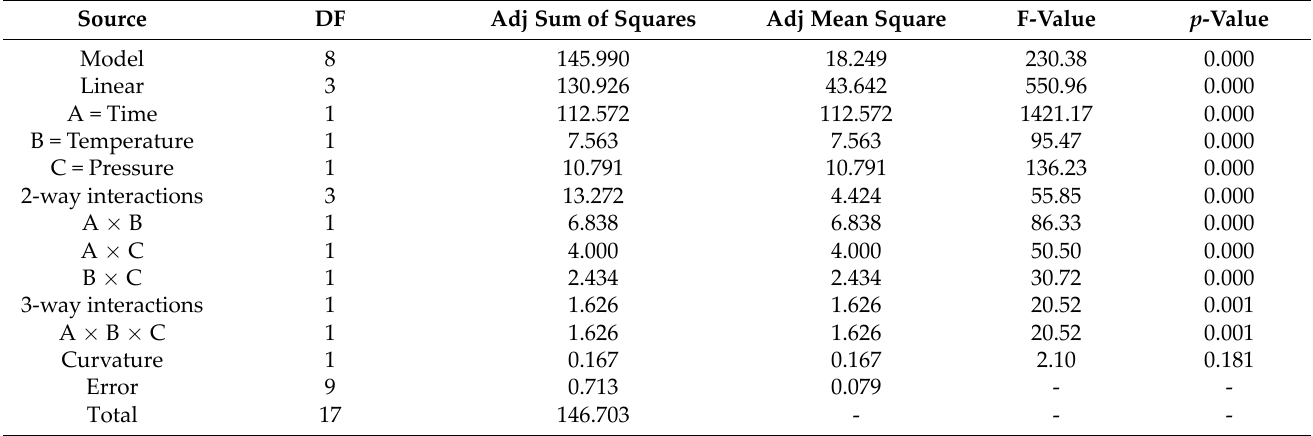
Table 3. ANOVA of the yield of collagen/gelatin extraction from the